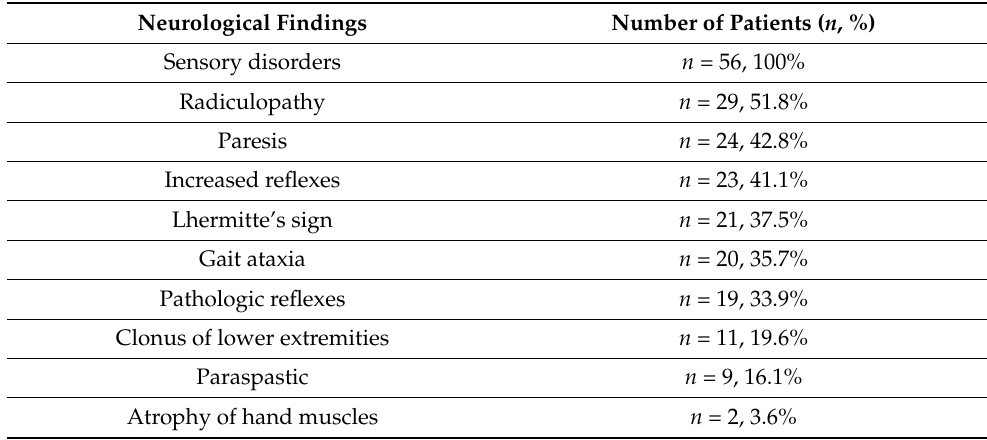
Table 1. Preoperative neurological findings; cohort size: n = 56